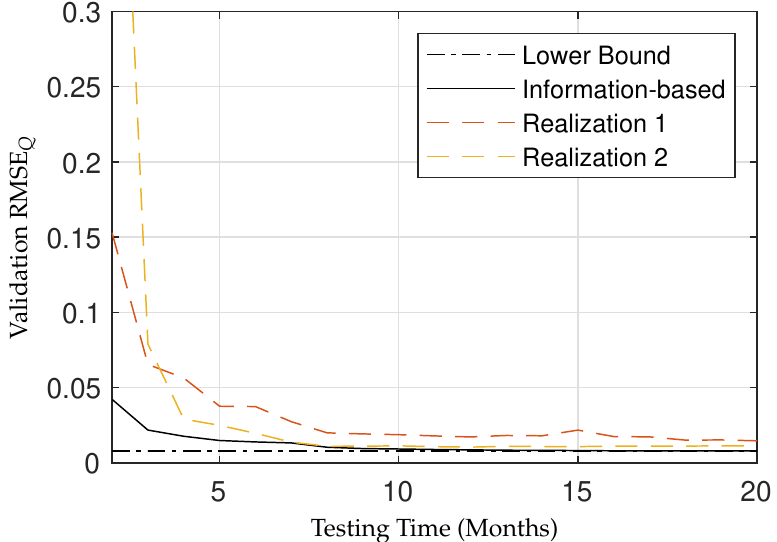
Figure 10. Validation RMSE versus total testing time for the 40 best cells and different selection strategies.